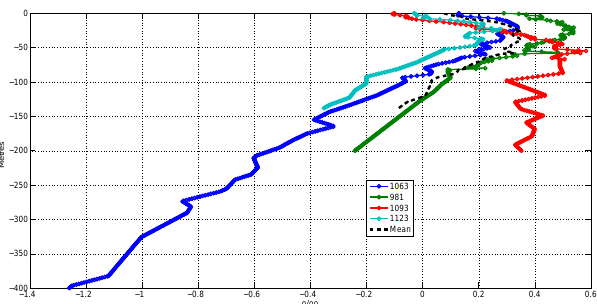
Figure 3. The four δ 18 O profiles used here along the mean value to the depth of the shallowest record (core 1123). Recall that the tops of the cores lie at different water